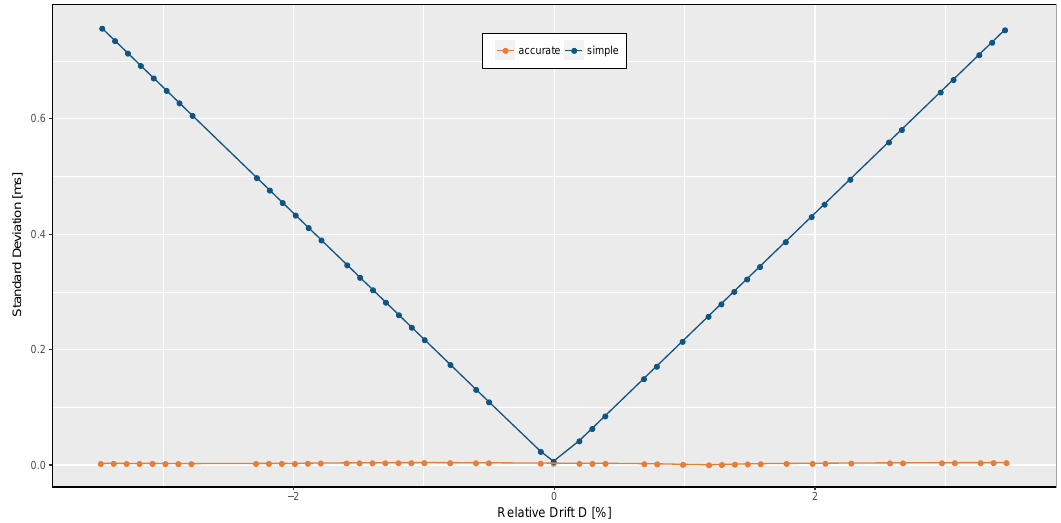
Figure 8. Comparison of simulated sample-to-sample distances for different relative drifts using simple and accurate time stamp reconstruction